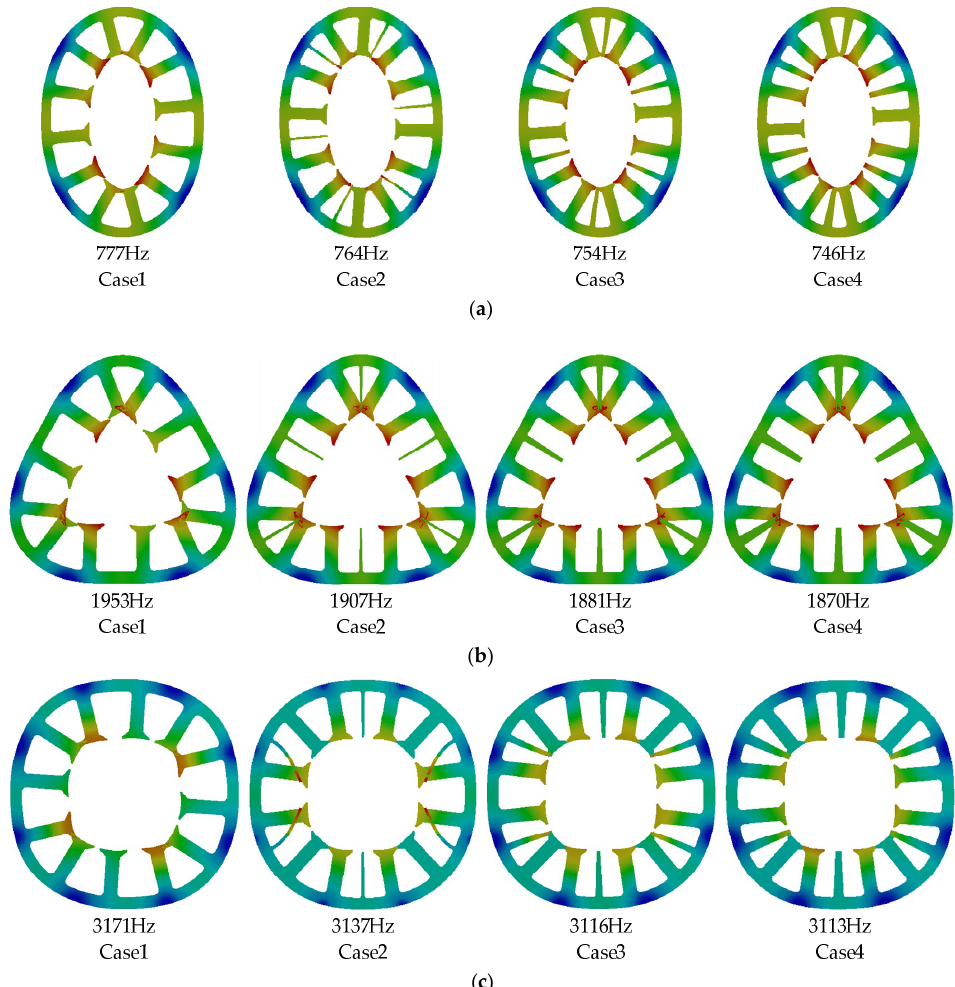
Figure 6. The model of the three-dimensional stator of PMSM.